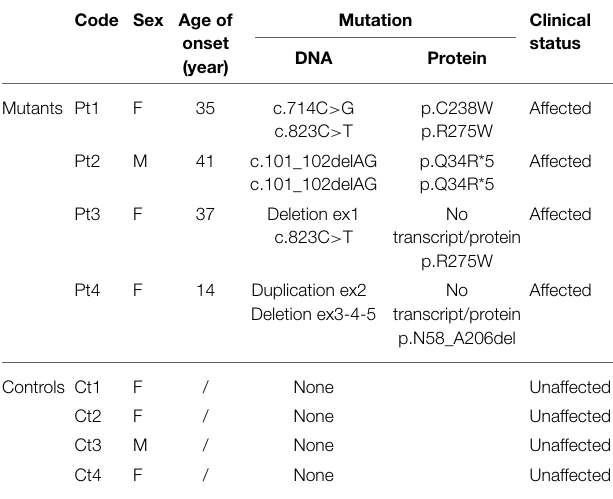
TABLE 1 | Genotypic and phenotypic characterization of investigated individuals. Code Sex Age of